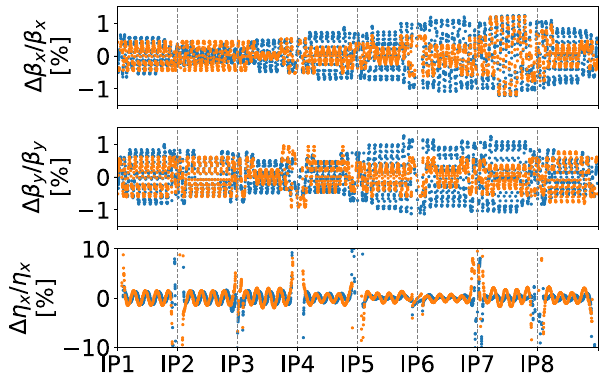
FIG. 20. Introduced β beating and dispersion ( η ) beating using 16 MQT families (blue) and using eight MQT families (orange) for trimming tunes by 0.01 with respect to nominal collision